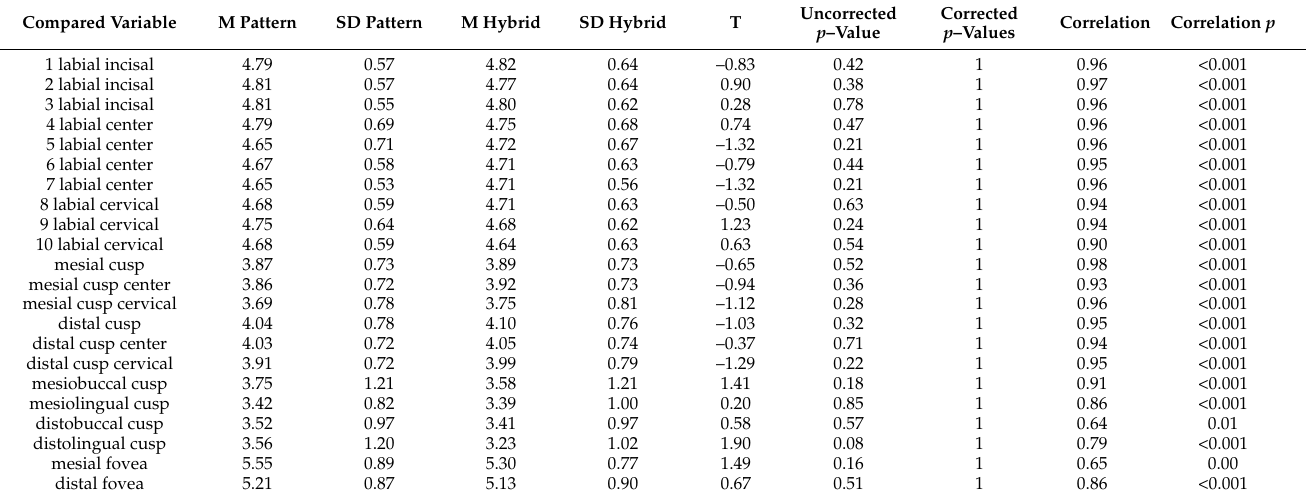
Table 1. Correlations between dimensions of the mouthguard patterns and hybrid mouthguards.